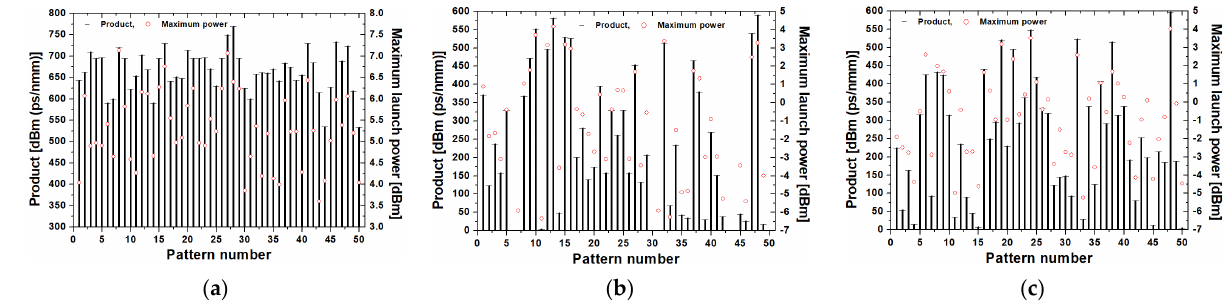
Figure 7. The product of NRD and launch power and the maximum launch power, which result in 1-dB EOP. ( a ) Random-inverse case, ( b ) random-follow case, and ( c ) all-random case. In the result of Figure 7a, the maximum launch power for pattern numbers 33 and 34 with similar product magnitudes are 4.2 and 5.2 dBm, respectively, with a difference of about 1-dB. This result means that in the dispersion-managed link designed with pattern number 33, the NRD can be generously selected as the maximum launch power and is lower compared to pattern number 34. Among the random-inverse distributions, the best product characteristic is obtained by applying pattern number 28, and since the maximum launch power is not too large, NRD can be applied with sufficient margin. On the other hand, in the dispersion-managed link designed by pattern number 8, although the product characteristic is relatively good, it is difficult to apply NRD with the margin due to the relatively large maximum launch power. In conclusion, the RDPS pattern in the random-inverse distribution should be determined and applied according to the specific requirements such as NRD margin and power margin. Figure 8a shows the dispersion maps made with the RDPS distribution pattern that can obtain the best compensation among random-inverse distributions. On the other hand, Figure 8b shows the distribution maps made with the RDPS distribution pattern with the least compensation effect among the random-inverse distributions. Analyzing the dispersion maps shown in Figure 8a, it can be recognized that the amount of accumulated dispersion (i.e., positive values) and the amount of offsetting dispersion (i.e., negative values) is intensively large at the beginning and the end of the same transmission path.